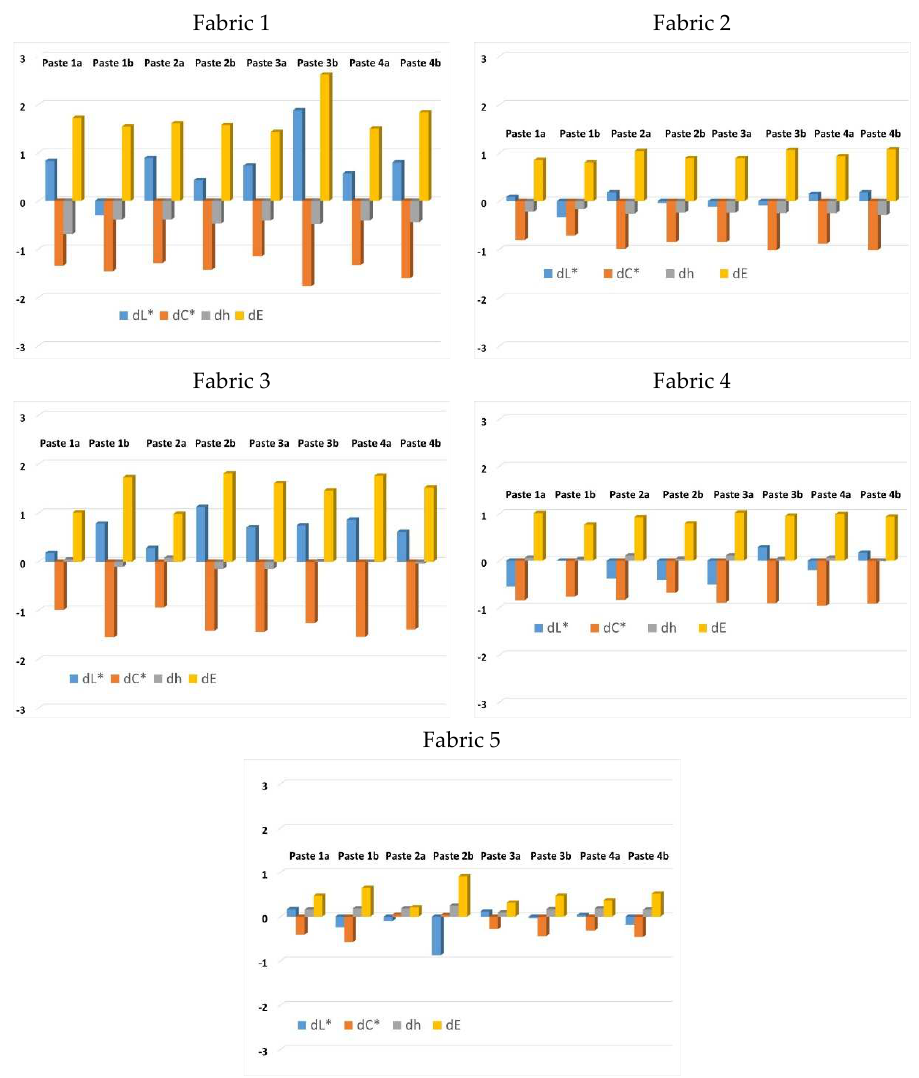
Figure 8. Color differences values calculated according to CIE76 formula. comparing values of unwashed samples with values obtained after 5th wash cycle.